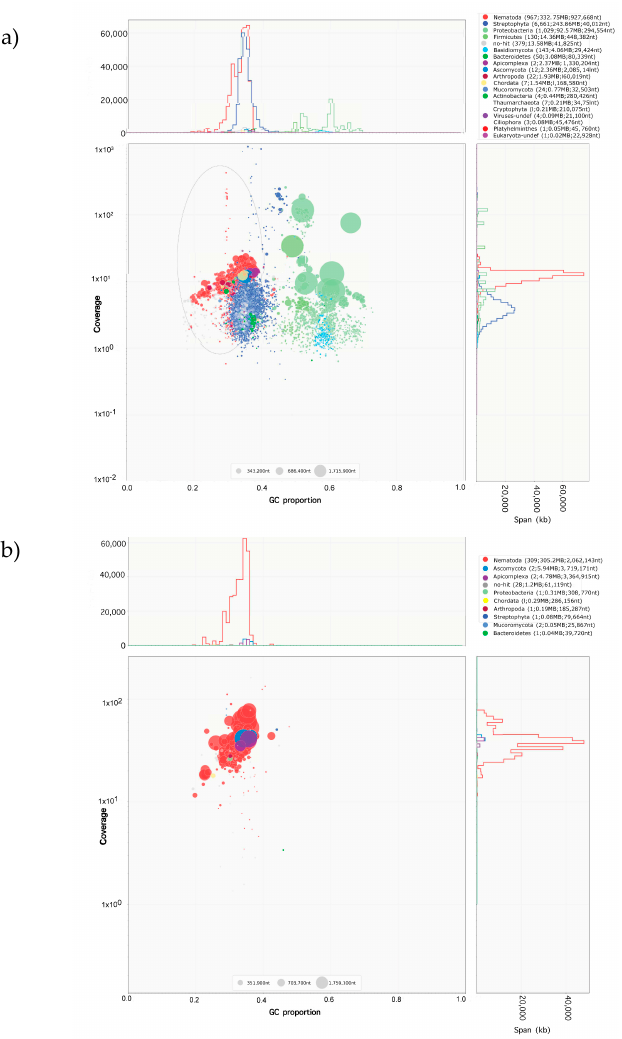
Figure 1. Blobplot contaminant analysis of Pratylenchus scribneri assembly obtained using two DNA extraction methods, before removing contaminants. The contig length is represented by circles pro- portionally scaled and colored by taxonomic annotation based on BLAST similarity search